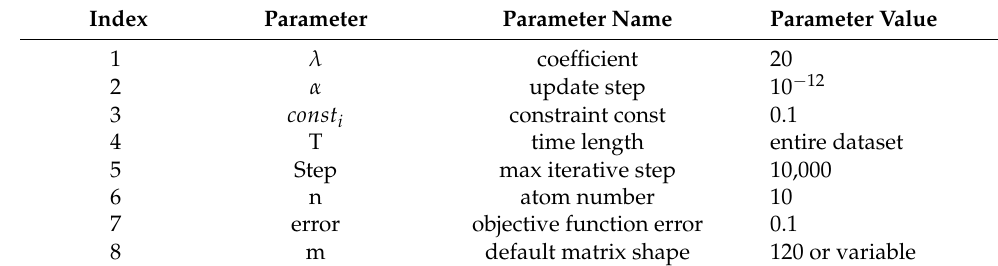
Table 3. Experiment parameters.